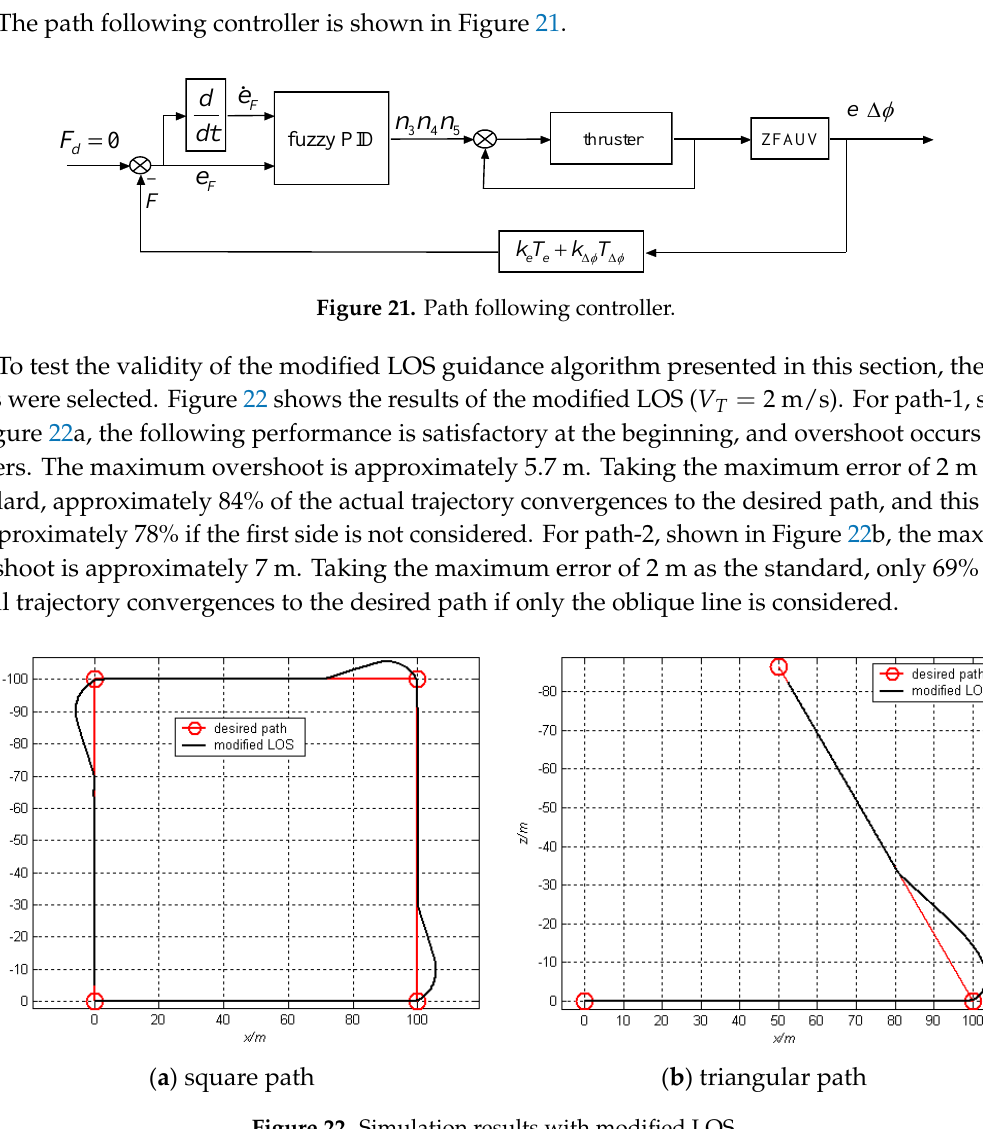
Figure 22. Simulation results with modified LOS.